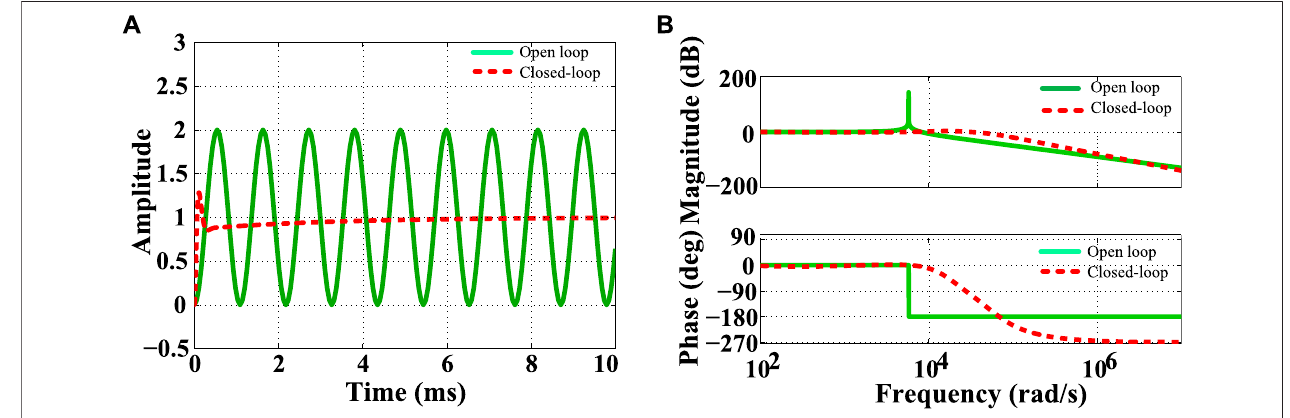
FIGURE 4 | Comparison of open-loop and closed-loop for secondary networks (SN): (A) Time-domain response; (B) Frequency-domain response.